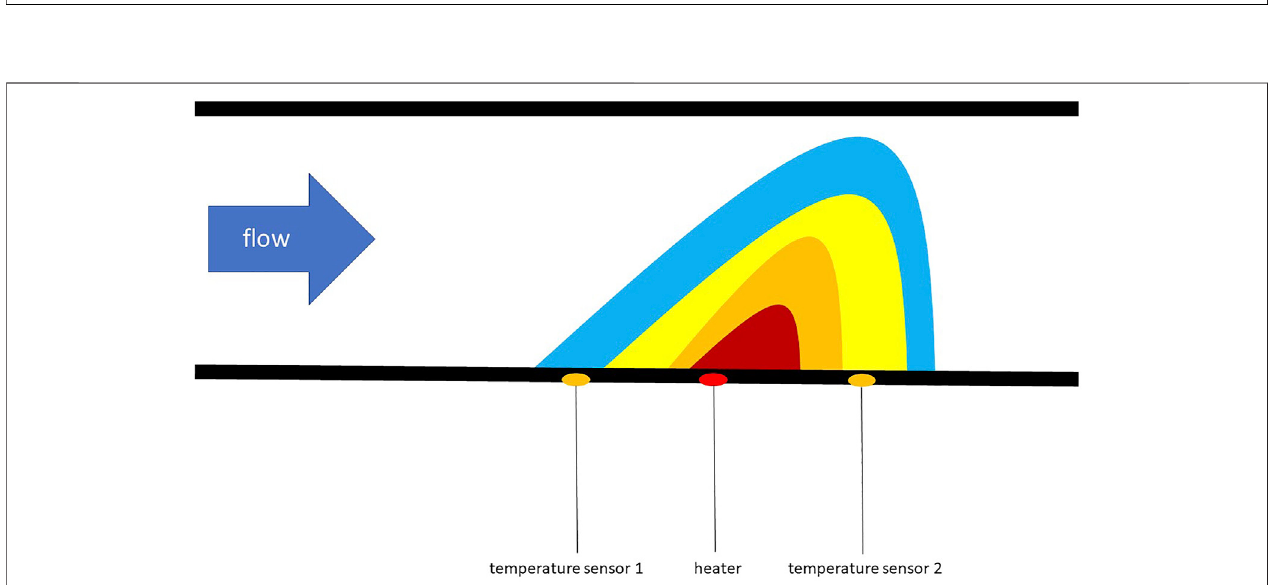
FIGURE 3 | Illustration of the thermal based measuring principle of the fl ow sensor adapted from Kuo (Kuo et al., 2012).